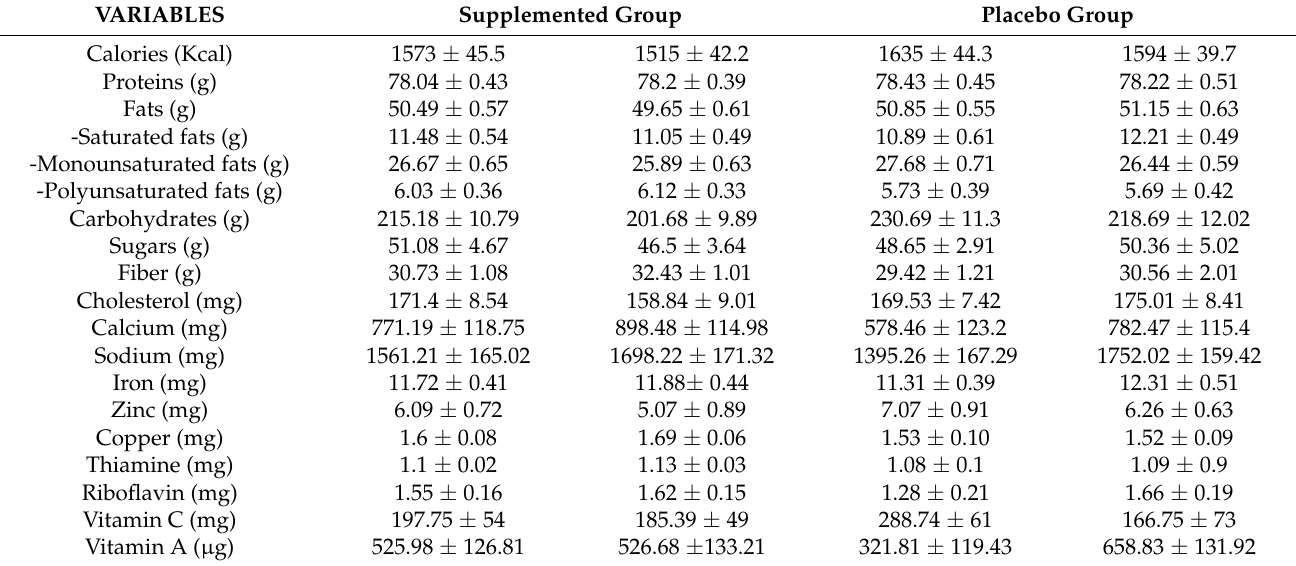
Table 9. Macro- and micronutrient